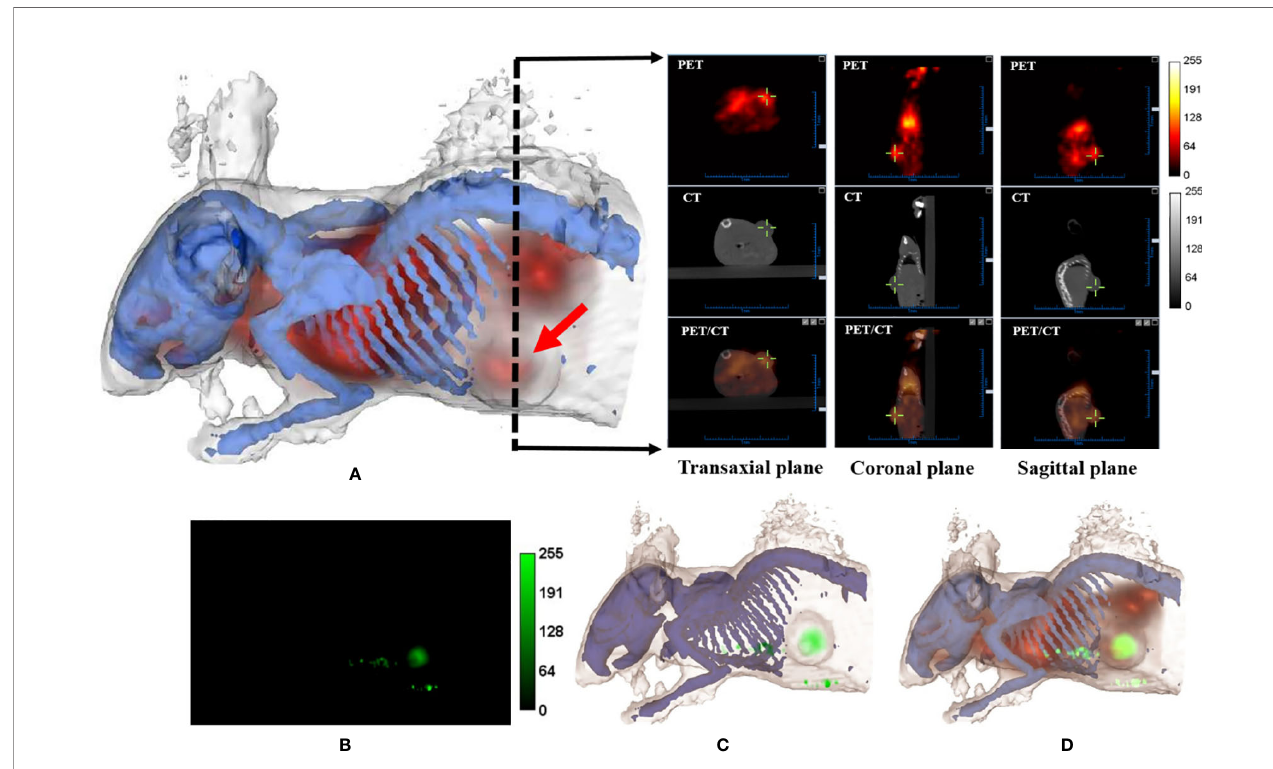
FIGURE 4 | Multi-modality imaging analysis of nude mice bearing WSU-HN6 xenograft tumors. (A) Three-dimensional rendering of mouse bones and skin based on CT data using 3D-Slicer. The PET (apoptotic) signal is merged with the rendering volume (red arrow, tumor). The black dashed arrow indicates the position of transverse slices in CT, PET, and merged PET/CT images in the transaxial, coronal and sagittal plane. (B) Fluorescence image (ICG signal, corresponding to necrotic tumor area) of a mouse obtained by FRI. (C) Three-dimensional rendering of mouse bones and skin and fl uorescence signal based on FRI. (D) Three-dimensional rendering of CT/PET/Fluorescence (red, apoptotic signal; green, necrotic